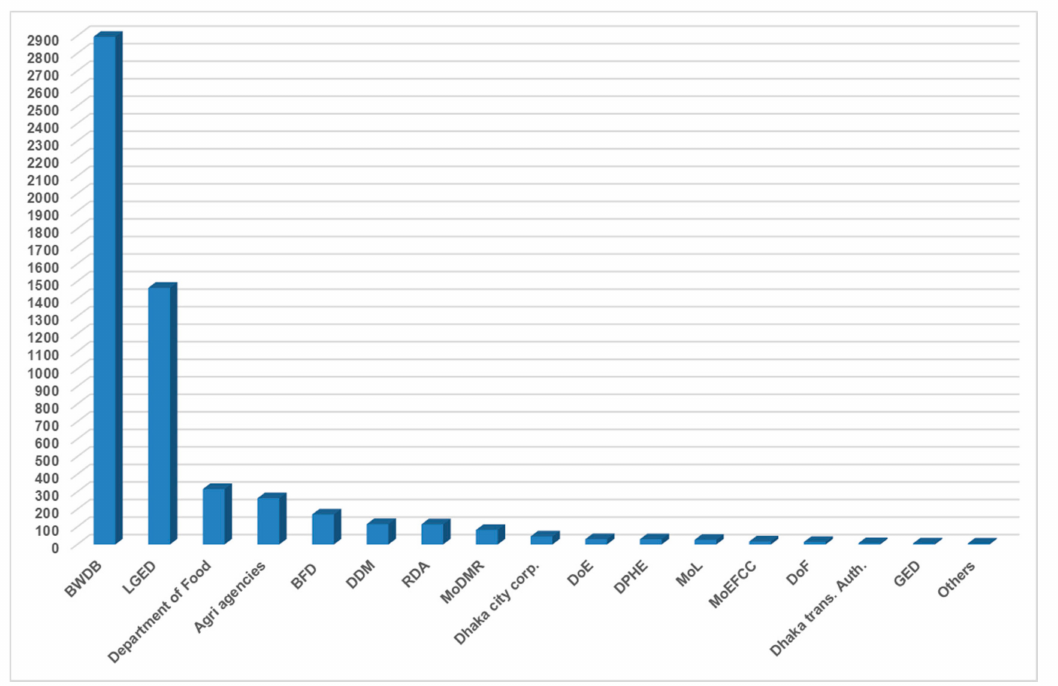
Figure 4. Implementation of climate adaptation funds by sectoral lead agencies based on Annual Development Program (ADP) projects from 2009 to 2017. Note: Data collected from Rahman and Tosun, (2018) and Bangladesh Planning Division website (https: // plandiv.gov.bd / ). Here, X-axis represents leading agencies which are responsible for implementing the climate adaptation